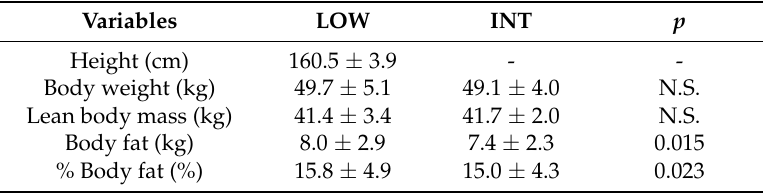
Table 1. Comparisons of physical characteristics over experiment period.